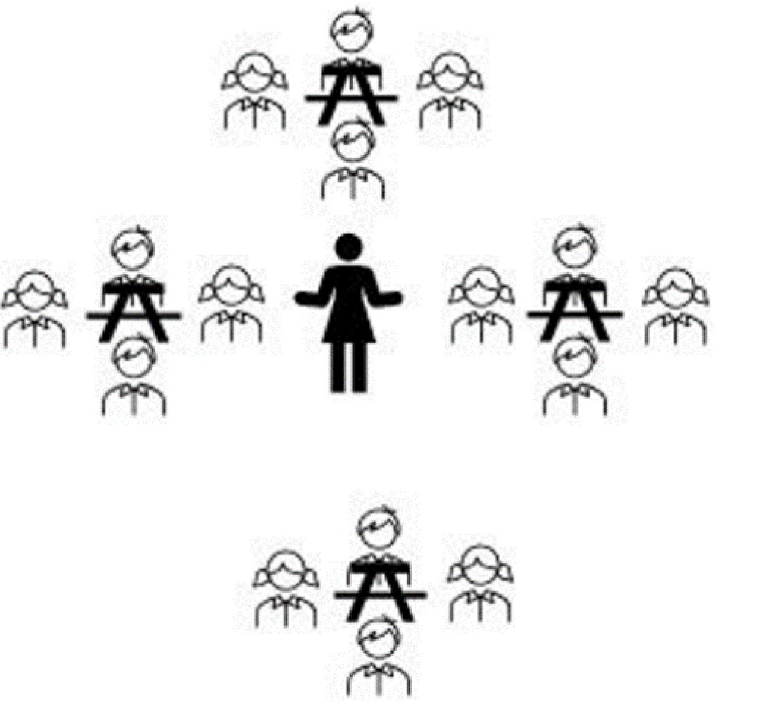
Fig 4. Mix-gender collaborative learning (groups of